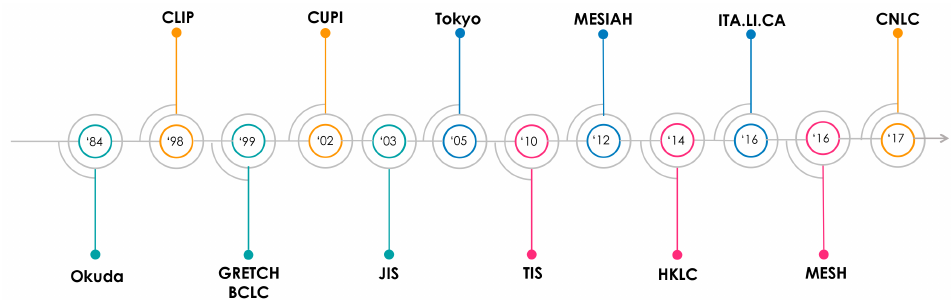
Figure 1. Hepatocellular carcinoma integrated prognostic systems proposed over